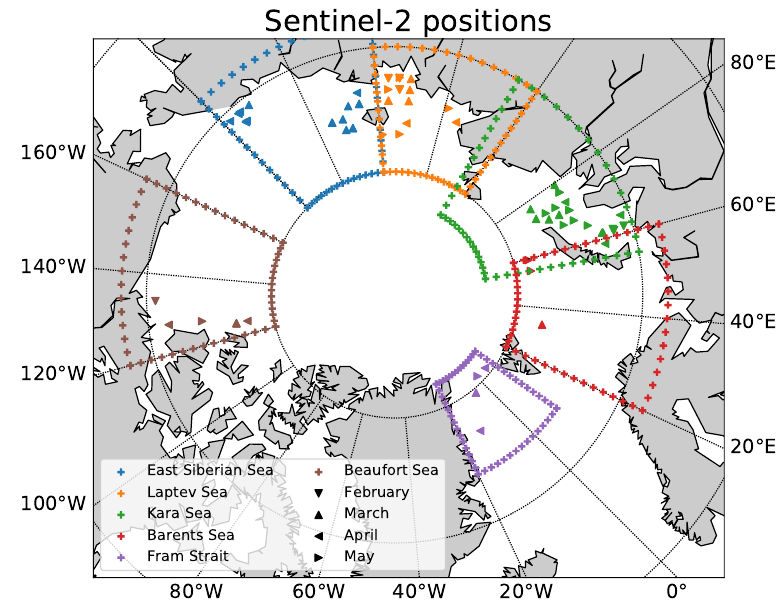
Figure 1. Locations of the Sentinel-2 scenes. The polygons mark the regions which are used for defining the marginal seas. Regions are indicated by colours and Months are indicated by the orientation of the triangles (see legend for details). All in all, 79 scenes are